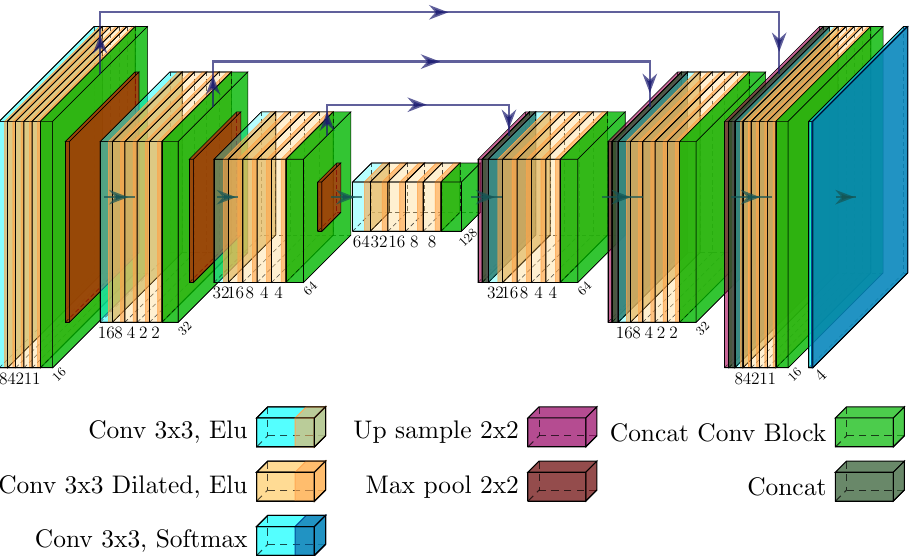
Figure 2. Our optimized small SDU-Net architecture. The input size is 256 × 256 pixels and we have 32 × 32 pixels at the lowest resolution. The number of channels is denoted at the bottom of the